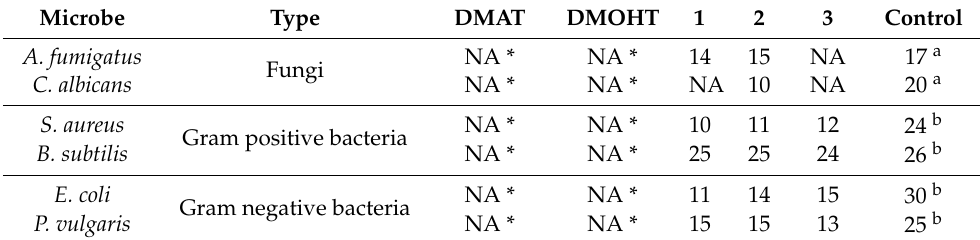
Table 5. Inhibition zone diameters (mm) for the tested microbes a